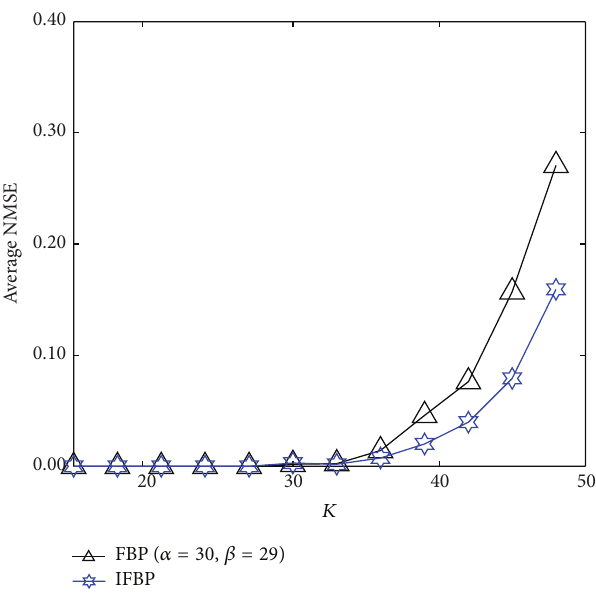
Figure 6: Average NMSE for the Gaussian sparse vectors ( 𝛼 = 30 , 𝛽 = 29 ).